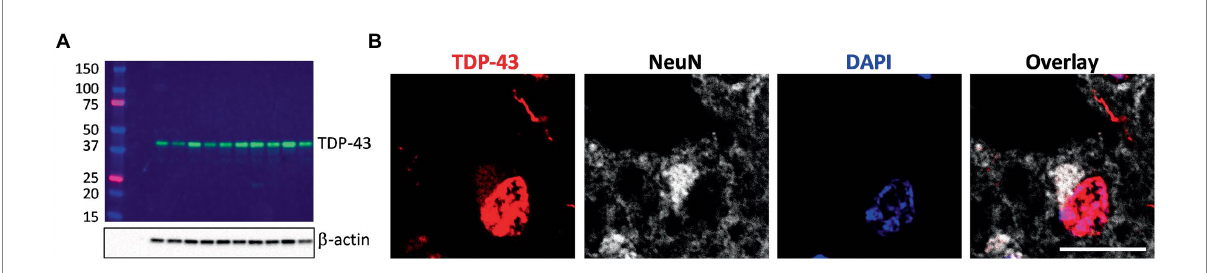
FIGURE 1 Verification of TDP-43 pathology in FTLD-TDP cases. (A) Western blotting of TDP-43 protein (43 kDa) in superior frontal cortex (SFC) in each FTLD-TDP (N = 10) cases; β -actin as a loading control; protein ladder (kDa). (B) Immunohistochemistry of neurons in FTLD-TDP SFC stained with TDP-43 (red), NeuN (grey), and DAPI (blue). Scale bar = 20 μ m.